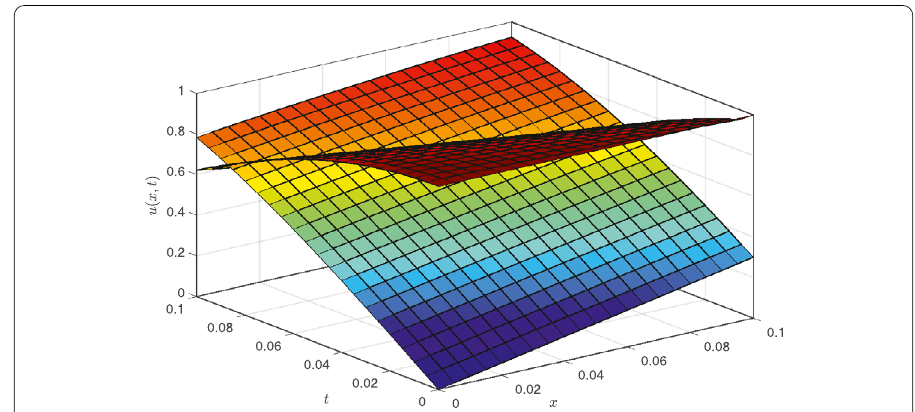
Figure 8 The approximate solution of Example 2 for Case 1 and α = β = 0.75